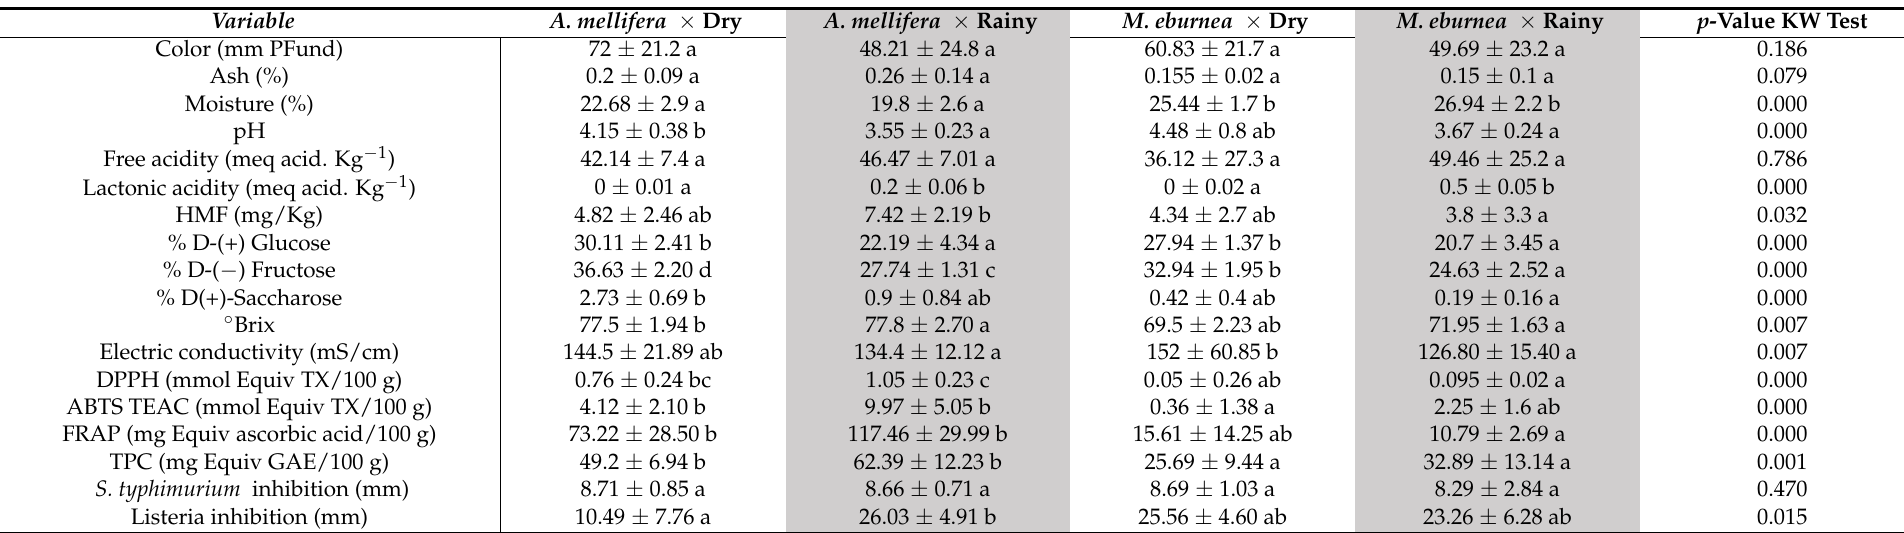
Table 1. Comparison of multiple ranges of Kruskall–Wallis for variables associated with the quality of honey produced by Apis mellifera and Melipona eburnea in the dry and rainy seasons in the Colombian Andean region. Different letters indicate significant differences between treatments according to the Kruskall–Wallis